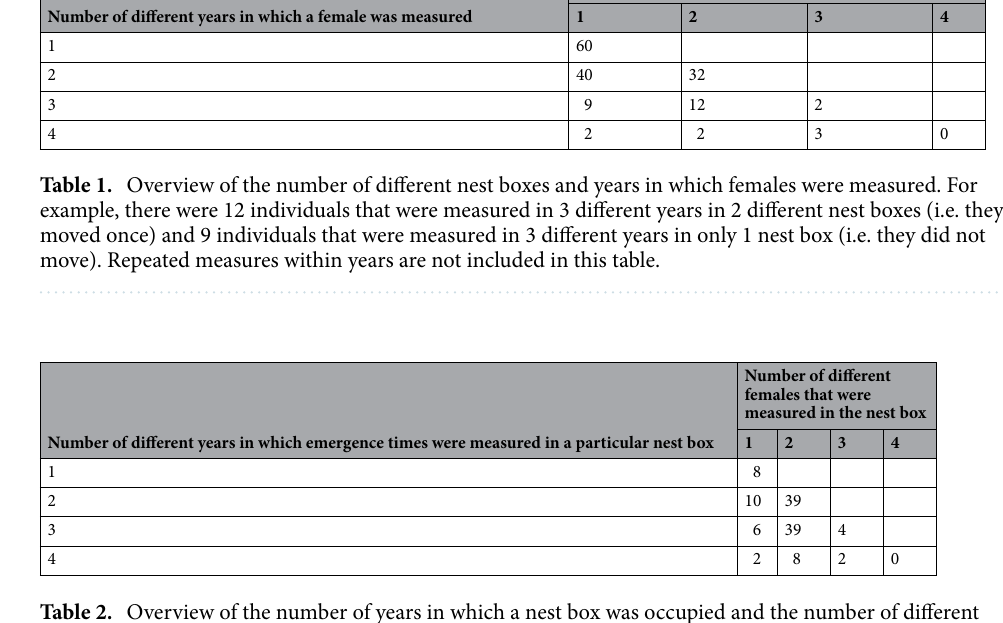
Table 2. Overview of the number of years in which a nest box was occupied and the number of different females that were measured inside a nest box. For example, there were 2 nest boxes that were occupied in 4 different years with 3 different individuals, and 8 nest boxes that were occupied in 4 different years with only 2 different individuals. Repeated measures within years are not included in this table.